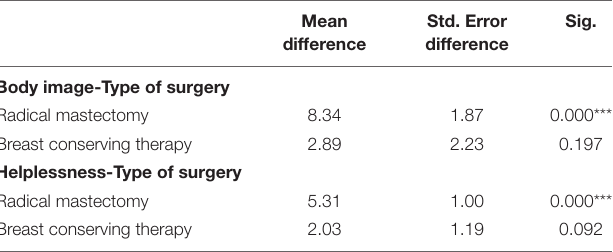
TABLE 3 | Simple effects: comparison between high and low alexithymia groups in different type of surgery.